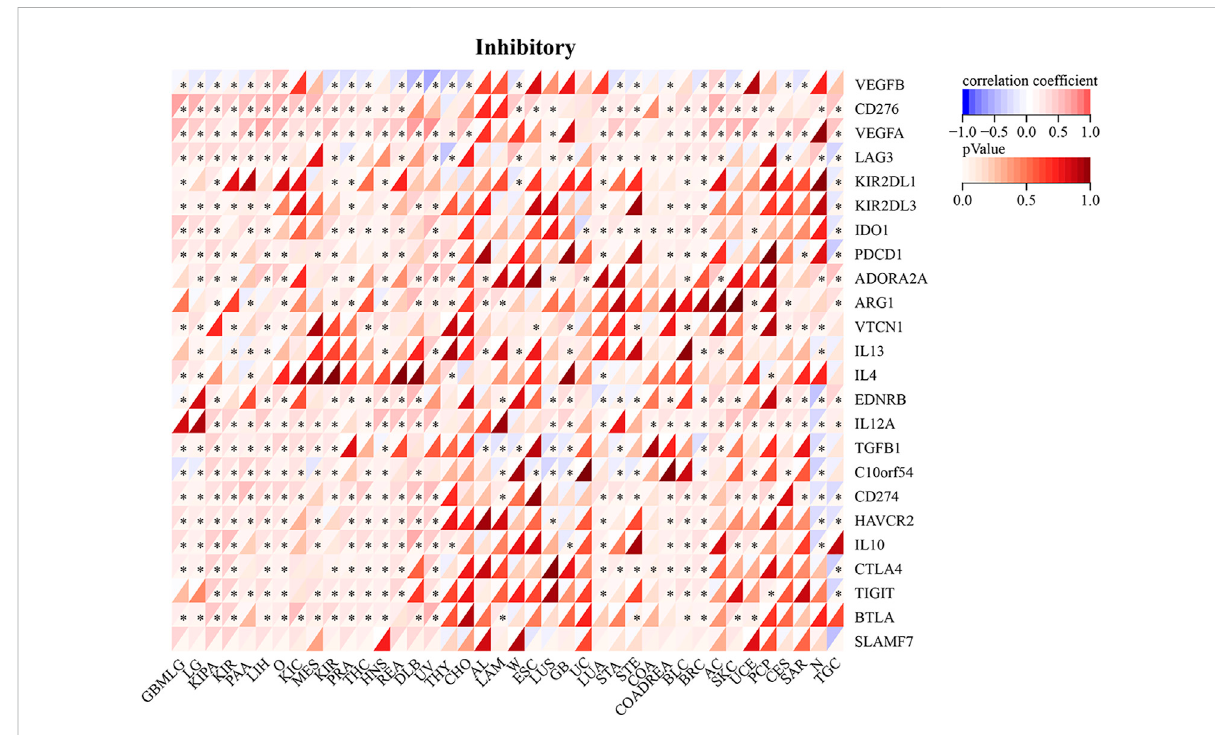
FIGURE 9 Relationship between RAD51AP1 and immune checkpoint inhibitory genes in pan-cancer. RAD51AP1 presented signi fi cant correlations